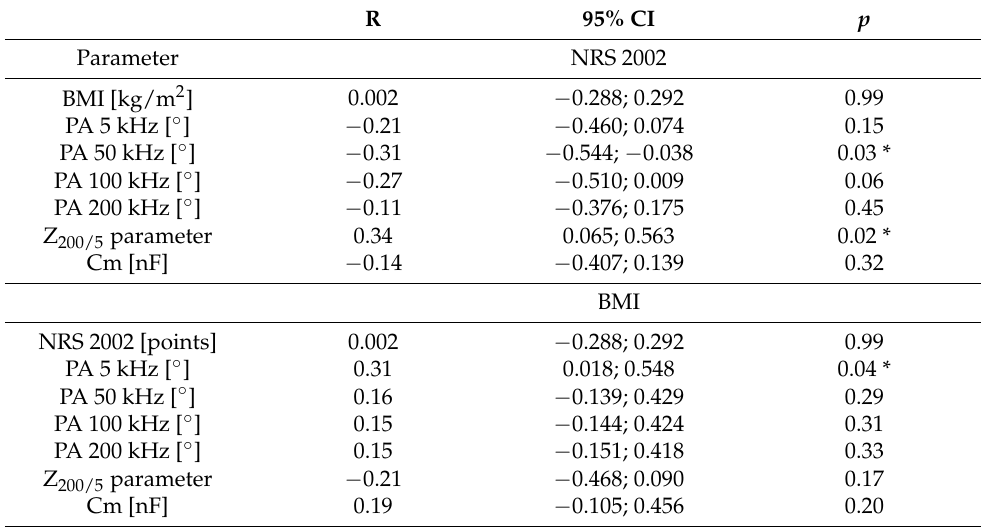
Table 1. Correlation between BMI, NRS and BIA parameters.